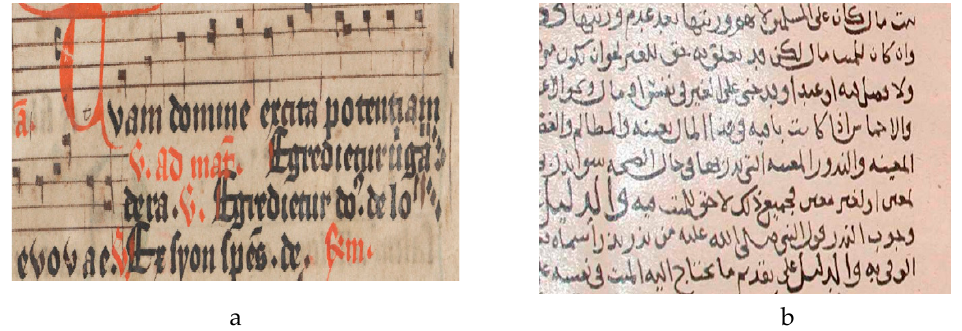
Figure 1. Source sample of different degraded documents; ( a ) music score [6], ( b ) historical document [8]. Figure1. Sourcesampleofdi ff erentdegradeddocuments; ( a )musicscore[6], ( b